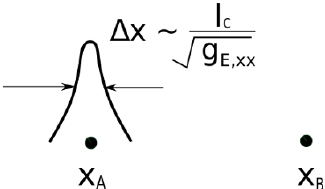
Figure 15 . ^ H ( x A ; E; (cid:27) ) has a spread over (cid:1) x (cid:24) l c p along x direction in the manifold. In the g E;xx presence of a large (small) mutual information between x A and x B , g E;(cid:22)(cid:23) is small (large) and the spread of the operator inserted at x A can (can not) reach x B . Therefore, the strength of coupling between x A and x B depends on entanglement of target states which determines the